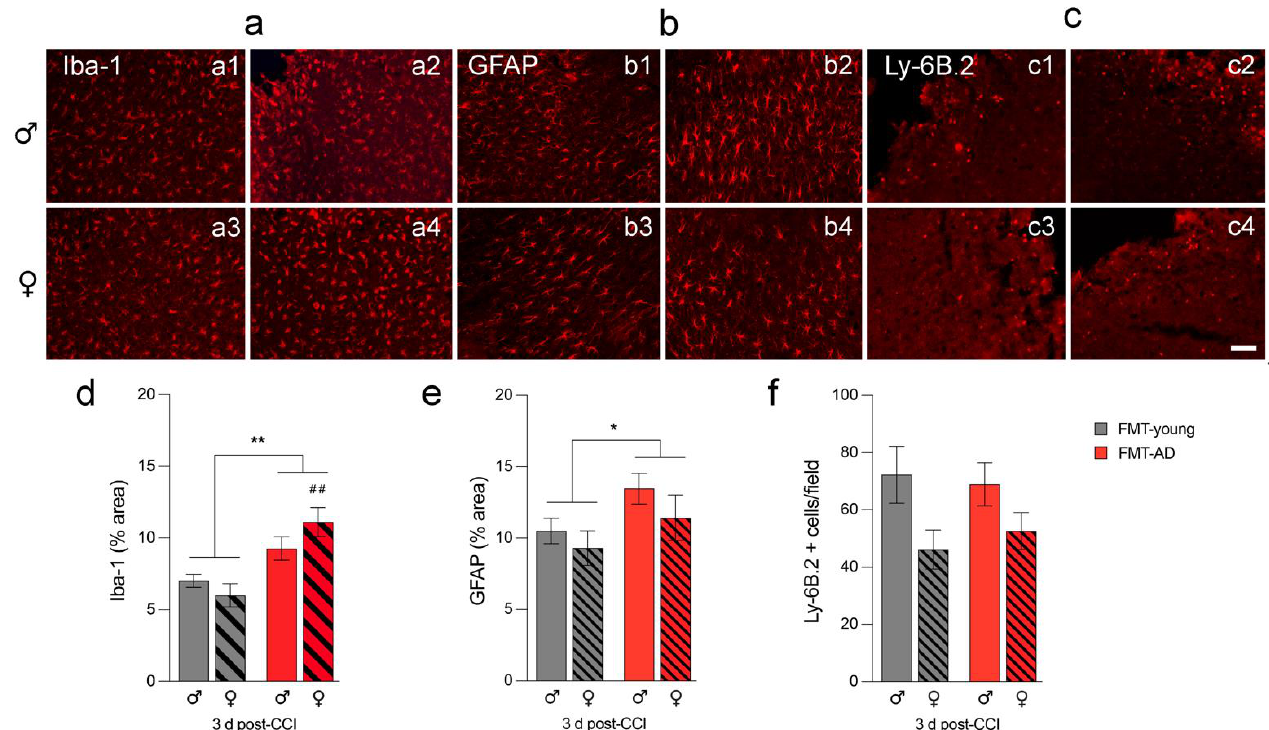
Figure 4. Microbiota from AD mice increased neuroinflammation in injured C57BL/6 mice. Glia activation increases in the pericontusional cortex after fecal matter transplants from AD mice (FMT-AD) compared to FMT from young mice (FMT-young). Representative immunofluorescence images indicate that FMT-AD compared to FMT-young induces an increased inflammatory response in mi- croglia/macrophages (Iba-1; a ( a1 – a4 )) and astroglia (GFAP; b ( b1 – b4 )), but no change in neutrophils (Ly-6B.2; c ( c1 – c4 )) at 3 days post-injury. The scale bar is 50 μm. The quantification graphs show a significantly higher area occupied by Iba-1 ( d ) and GFAP ( e ) positive cells in FMT recipients from AD mice. ( f ) The number of cells Ly-6B.2 not significantly changed in the FMT-AD mice. n = 5. * p < 0.05, ** p < 0.01 (ANOVA), ## p < 0.01 (post-hoc test).